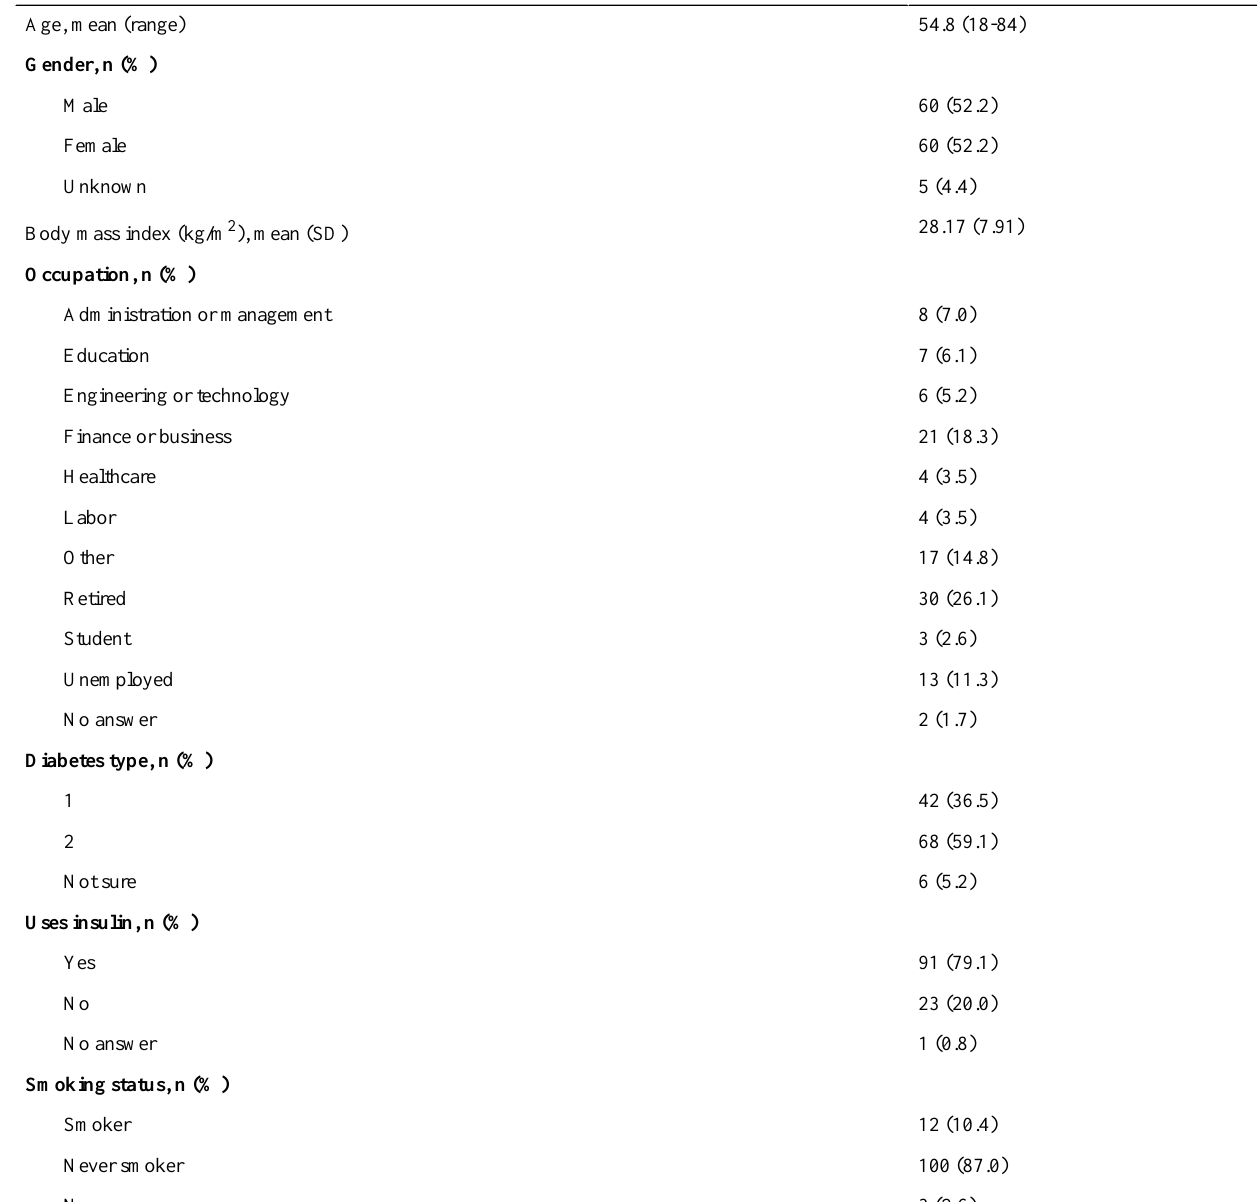
Table 1. Summary of patient demographic data and survey